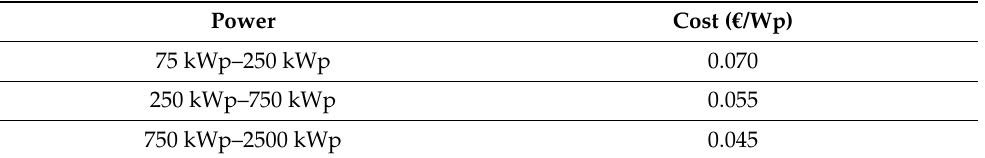
Table 8. Proposed cost of inverter in € /Wp (year